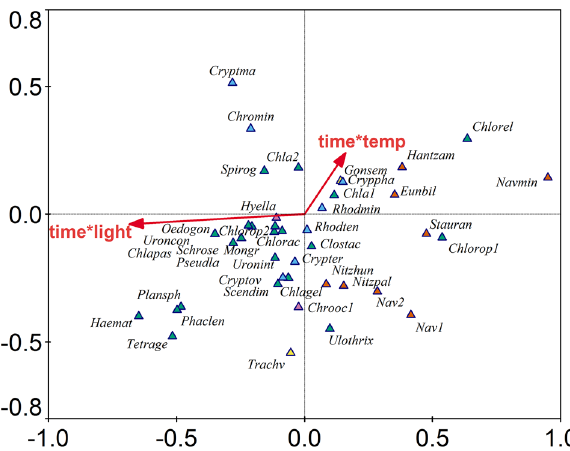
Figure 6. Results of CCA illustrating the phytoplankton species distribution over time and the environmental variables (time*temp—temperature over time, time*light—photoperiod length over time). For abbreviations see S2.4. The graph was created using the Canoco 4.56 software package and the data in